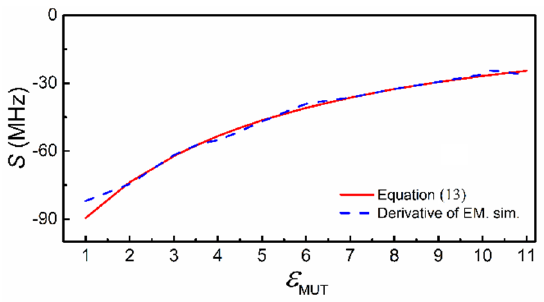
Figure 8. Sensitivity inferred from theory and from electromagnetic simulation.